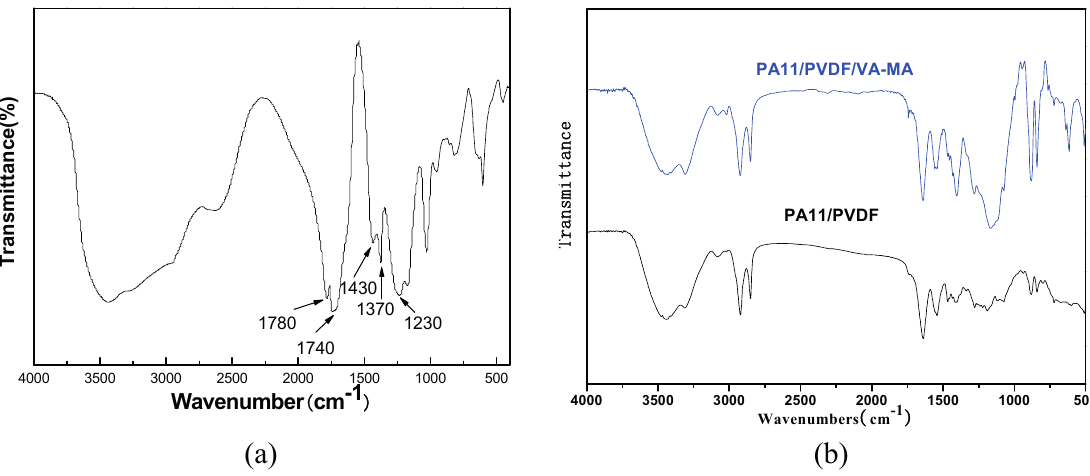
Figure 7. The FT-IR spectrum of ( a ) copolymer VA-MA and ( b ) PA11/PVDF (40:60)